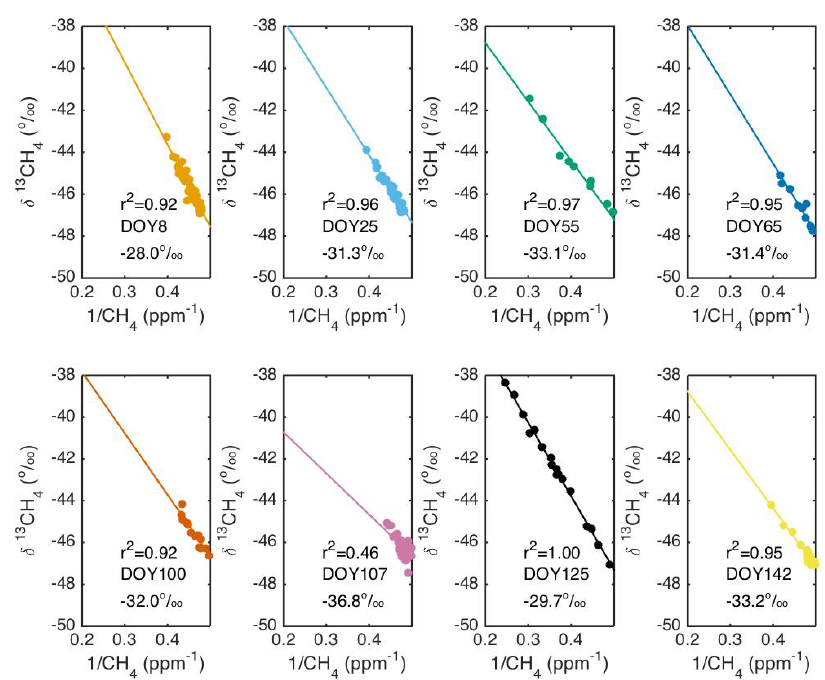
Figure 17. Keeling plots for the central tower for the eight largest peaks in the non-afternoon methane time series. Black lines indicate the best-fit lines. Correlation coefficients ( r 2 ) , day of year (DOY), and y intercepts are indicated in the